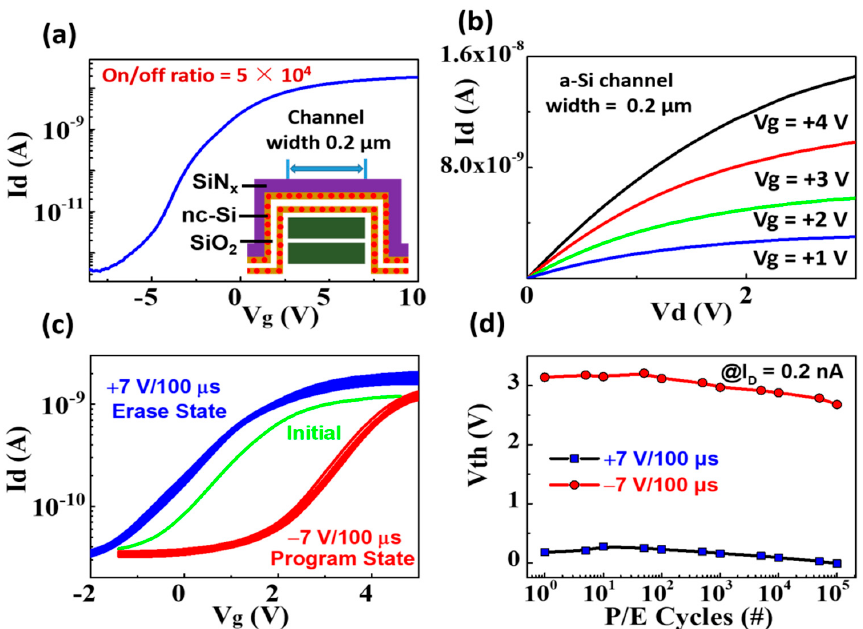
Figure 6. ( a ) The transfer characteristics of the 3D flash memory with the channel width of 0.2 µm (Vd = +1 V), ( b ) the output characteristics of the 3D flash memory with the channel width of 0.2 µm, ( c ) the transfer characteristics after programming and erasing operations at +7 V and − 7 V with 100 µs pulse, ( d ) endurance characteristics during the 105 P/E cycles operations at +7 V and − 7 V with 100 µs pulse.